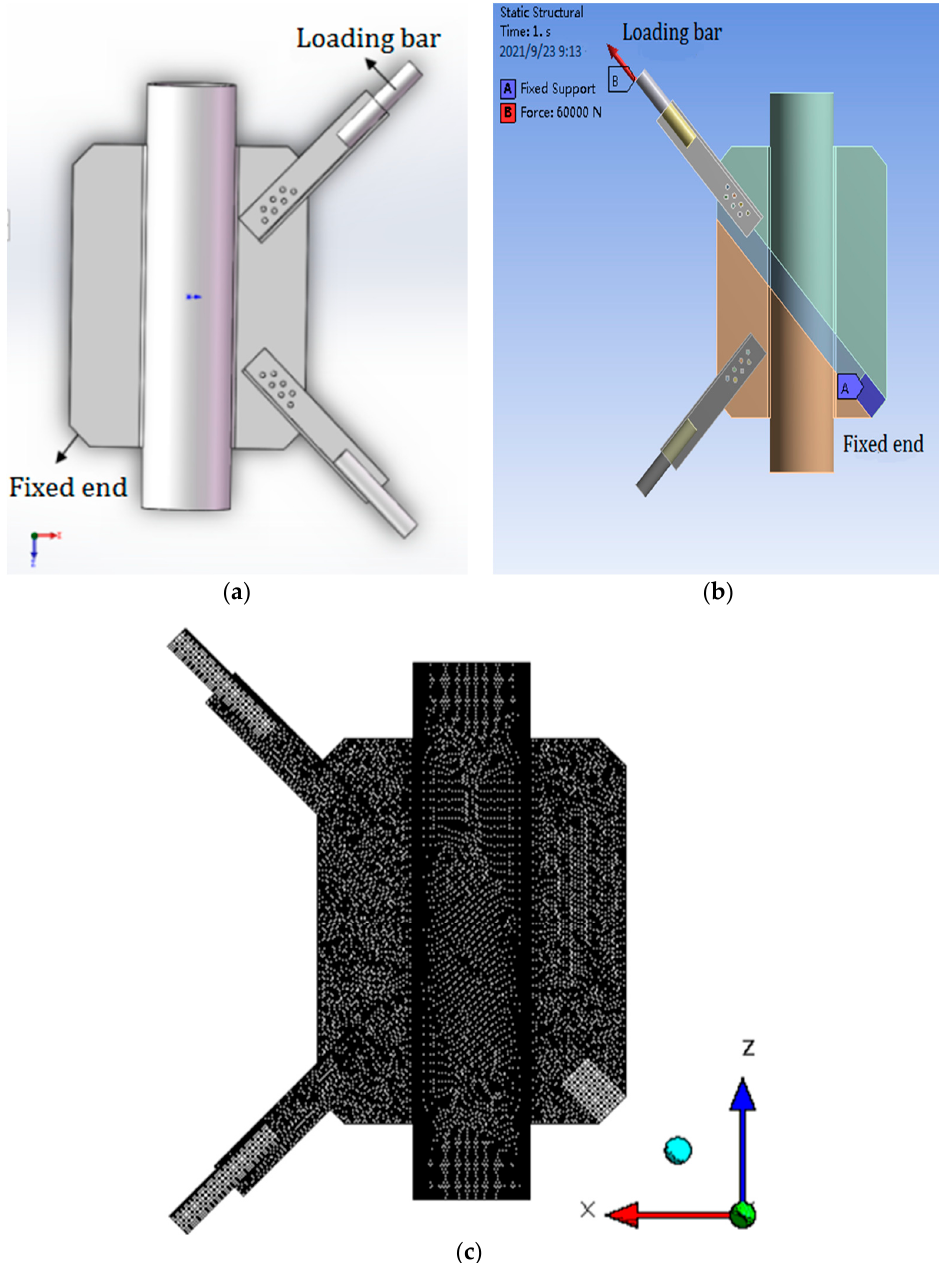
Figure 13. ( a ) Finite element model of PSLSPJ; ( b ) loading diagram of PSLSPJ; ( c ) meshing diagram of PSLSPJ.